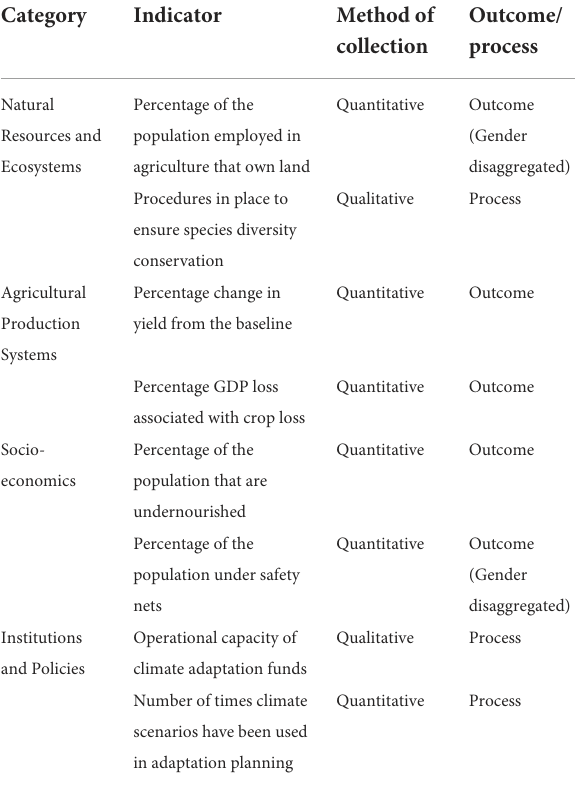
TABLE 1 Selection of adaptation tracking indicators from the TAAS framework (Ramasamy,